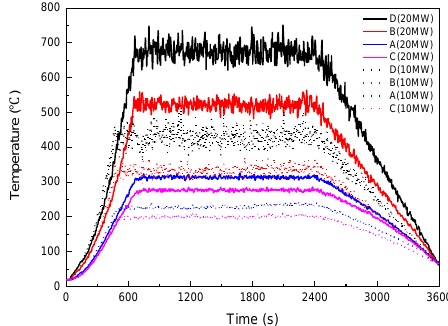
Figure 12. Air temperature at each monitoring point.